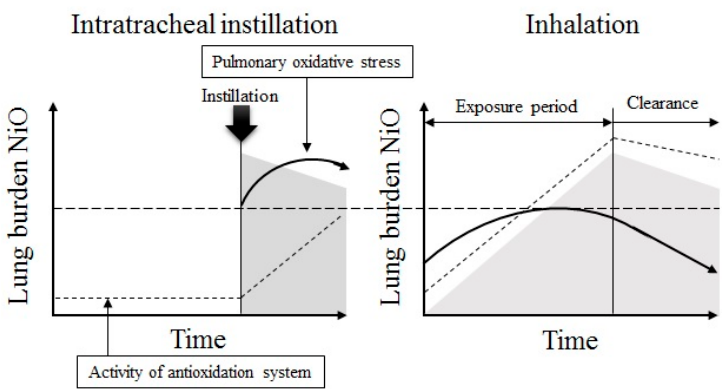
Figure 8. Estimated oxidative stress induction in intratracheal instillation and inhalation of NiO nanoparticles. If the amount of NiO in the lung is similar, the general pulmonary oxidative stress response is similar between intratracheal instillation and inhalation. The difference in oxidative stress strength depends on the induction of anti-oxidative system.